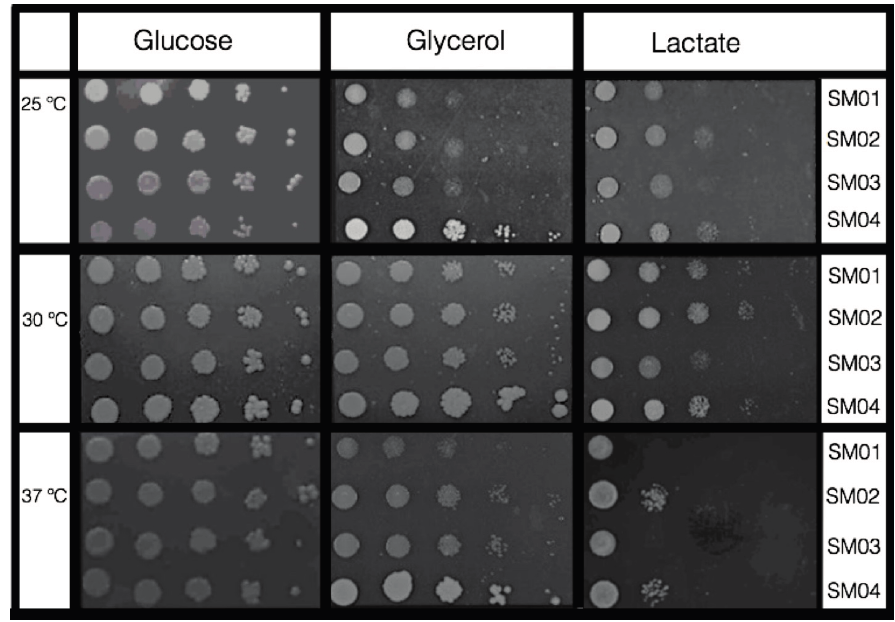
Figure 5. Temperature and carbon source-dependent growth of S. cerevisiae transformants harboring either plasmid pRS313 or pLBF01. Lines (fiveserial 1:10 dilutions): (1) SM01; (2) SM02; (3) SM03; (4)